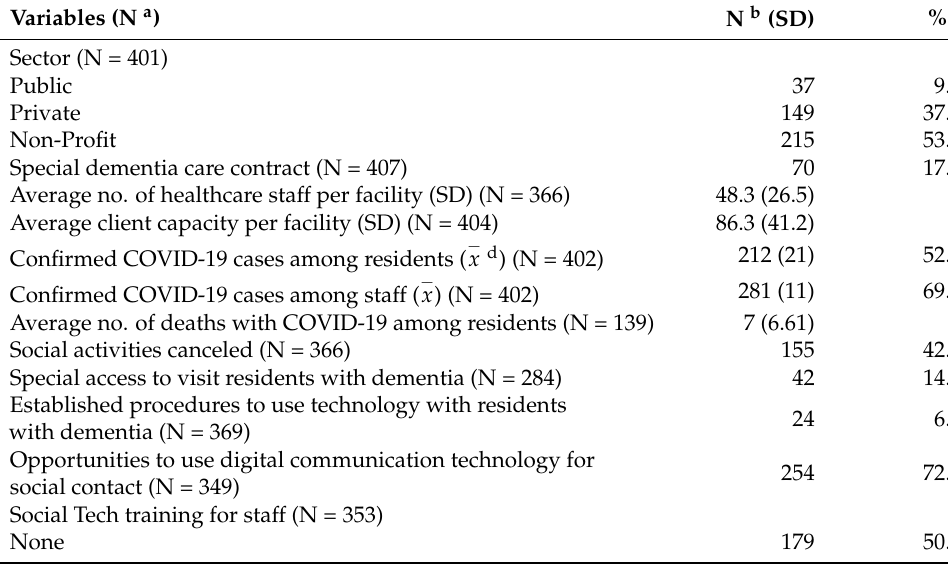
Table 1. Summary of findings according to facility